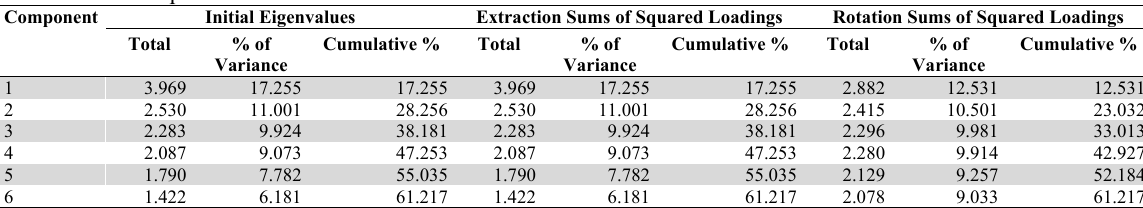
Total Variance Explained Component